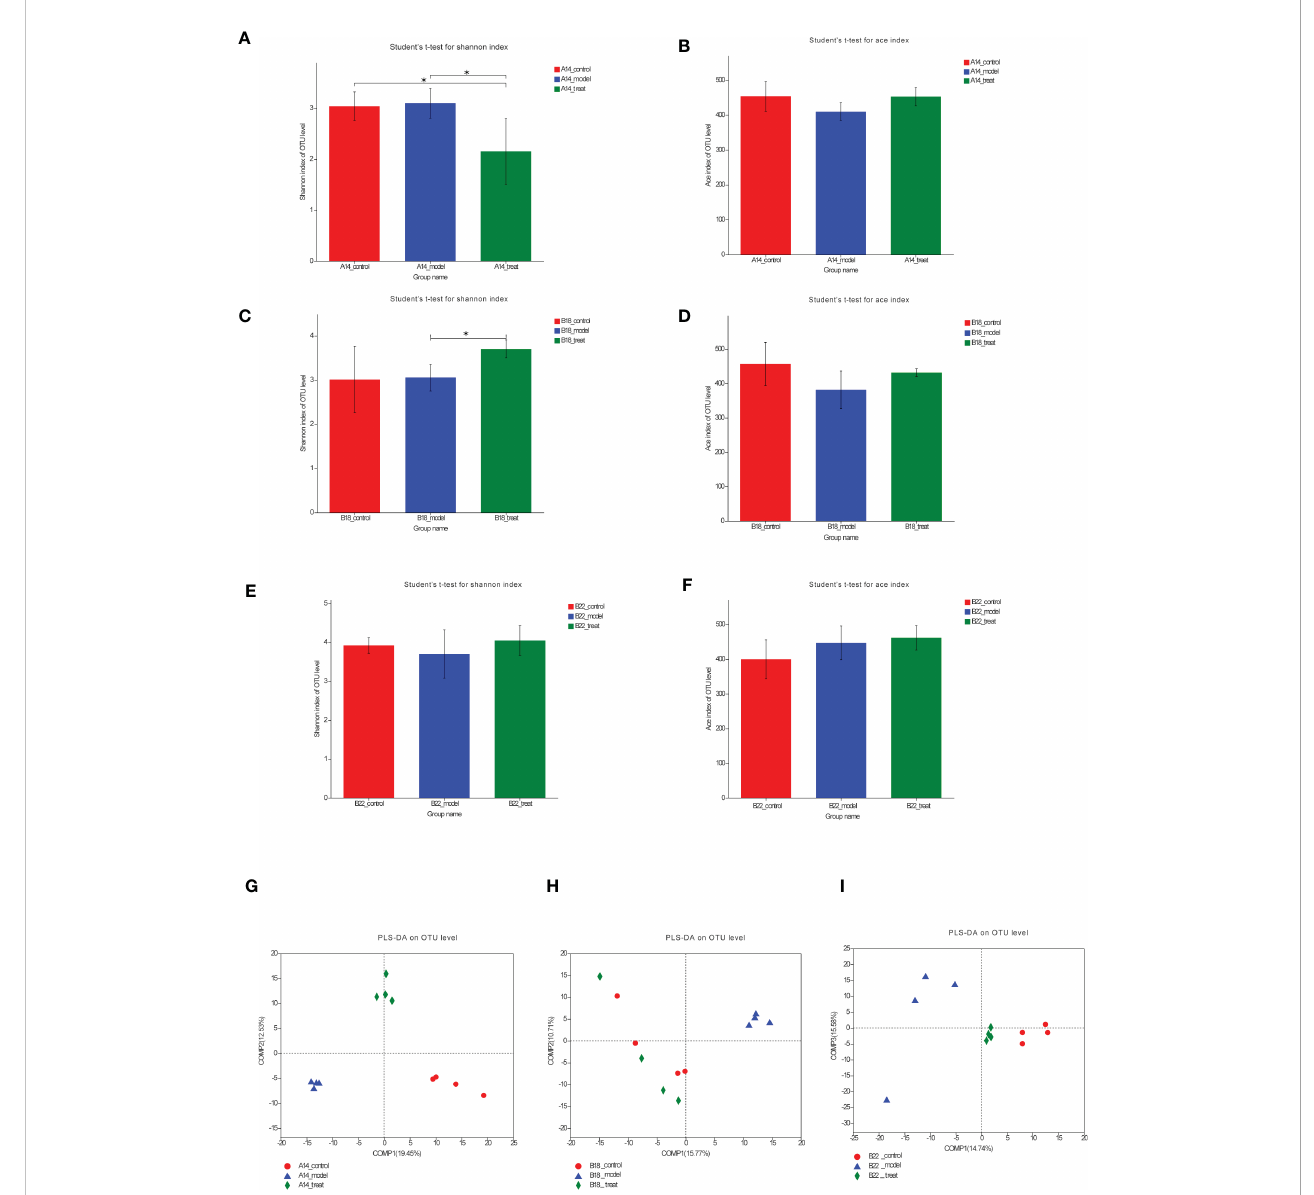
FIGURE 3 DAPA gradually modulates the overall structure of the gut microbiota in db/db mice. (A, C, E) Shannon diversity and ace richness (B, D, F) of fecal samples across three groups OUT at 14 weeks (14w), 18 weeks (18w), and 22 weeks (22w). (G – I) PLS-DA of OTU-level Bray-Curtis at 14w, 18w, and 22w. n = 4/group. Data are expressed as mean ± SEM. Statistical signi fi cance was calculated using ANOVA with Tukey's test. *p < 0.05. PLS-DA, partial least squares-discriminant analysis. The treat group means model + DAPA